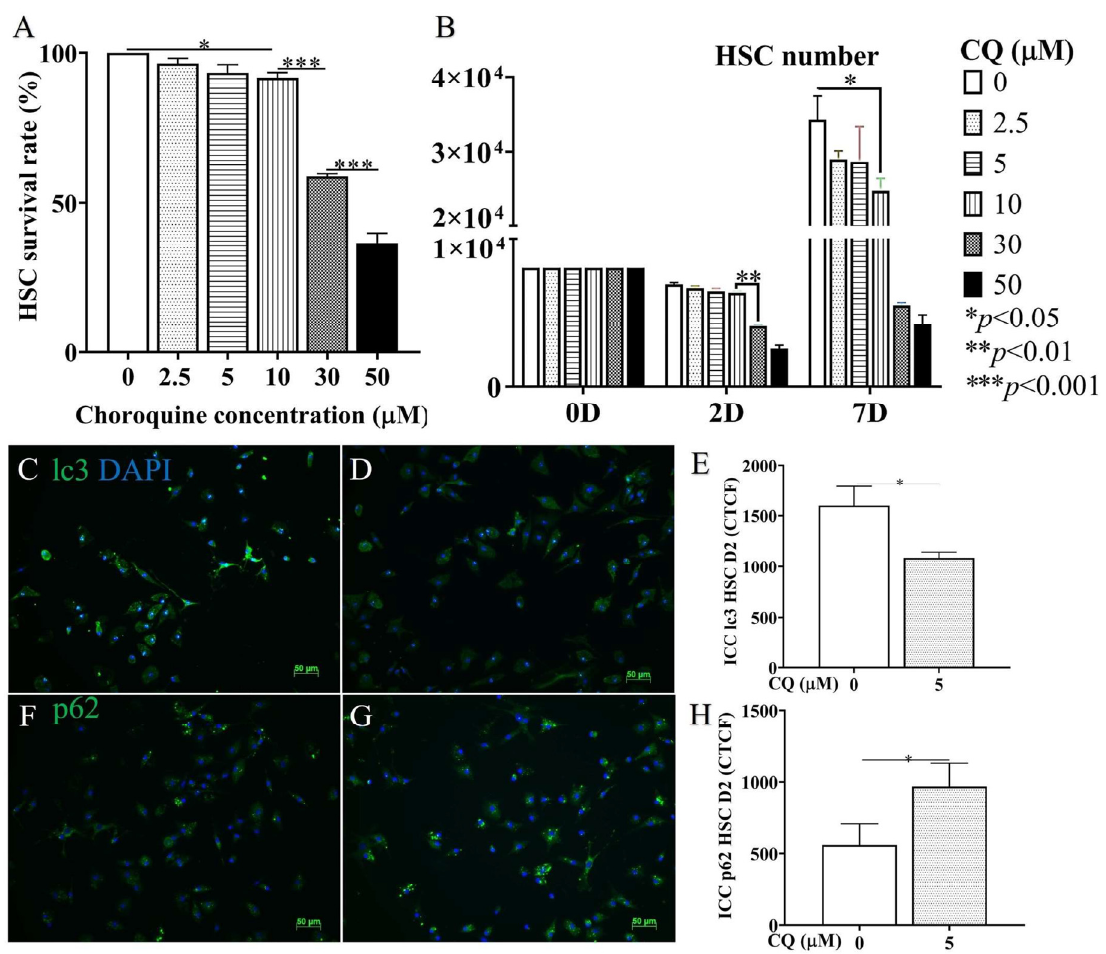
Figure 6. CQ cytotoxicity and autophagy effectiveness on HSCs in vitro. ( A , B ) Graphic comparison of CQ concentrations varying between 0, 2.5, 5, 10, 30, and 50 µM based on cytotoxicity and proliferation until 7D of culture ( B ) and 2D ( A ). ( C , D ) Representative images of ICC staining with lc3 antibody/DAPI of in vitro HSCs treated with 0 and 5 µM of CQ. ( E ) Graphic comparison of CTCF (Correct Total Cell Fluorescence quantification) from ICC staining. ( F , G ) Representative images of ICC staining with p62 antibody/DAPI of HSC treated with 0 and 5 µM of CQ. ( H ) Graphic comparison of CTCF from ICC staining. p -value: * < 0.05, ** < 0.01, *** < 0.001, n = 3, 50 µm scale bar.